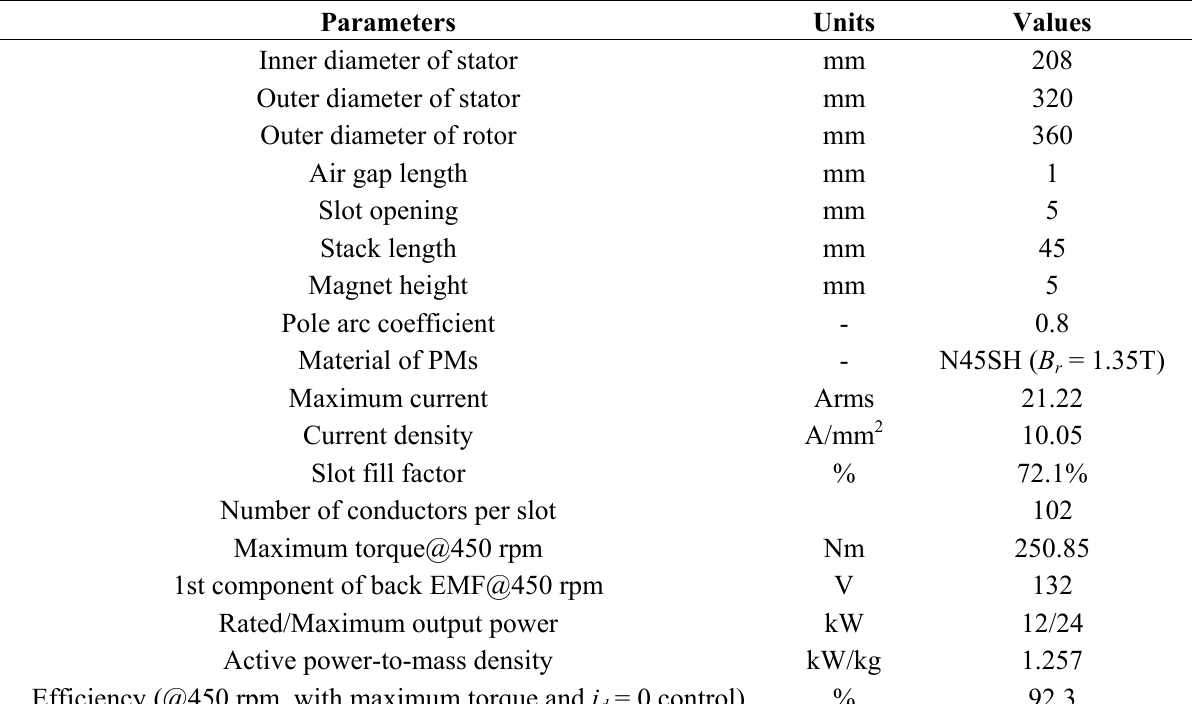
Table 4. Key parameters and dimensions of the original design.